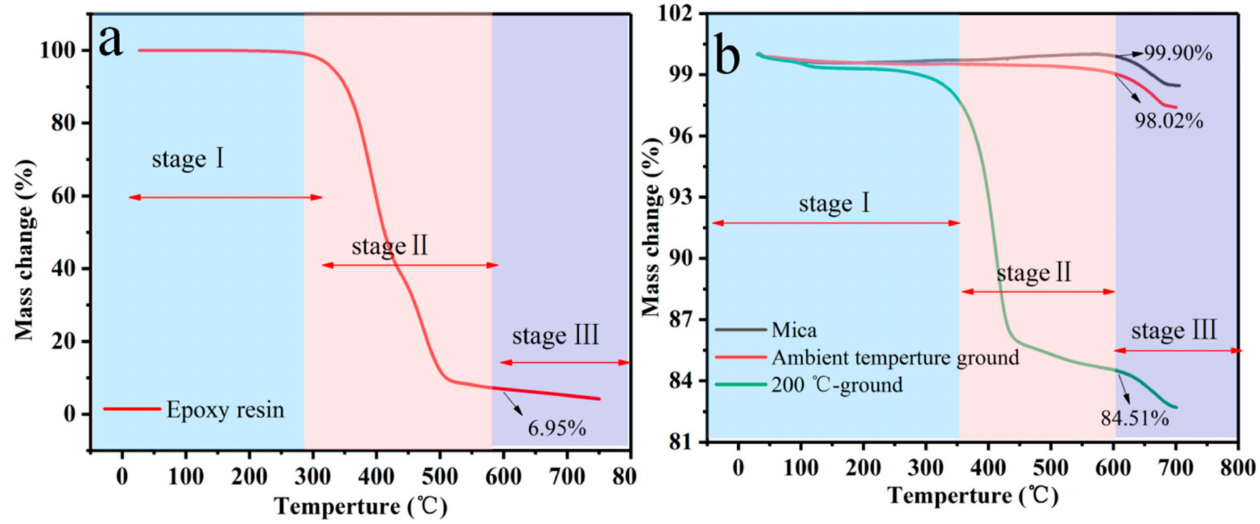
Figure 3. TGA curves of ( a ) epoxy resin and ( b ) raw mica, mica ground at room temperature, and mica ground at 200 ◦